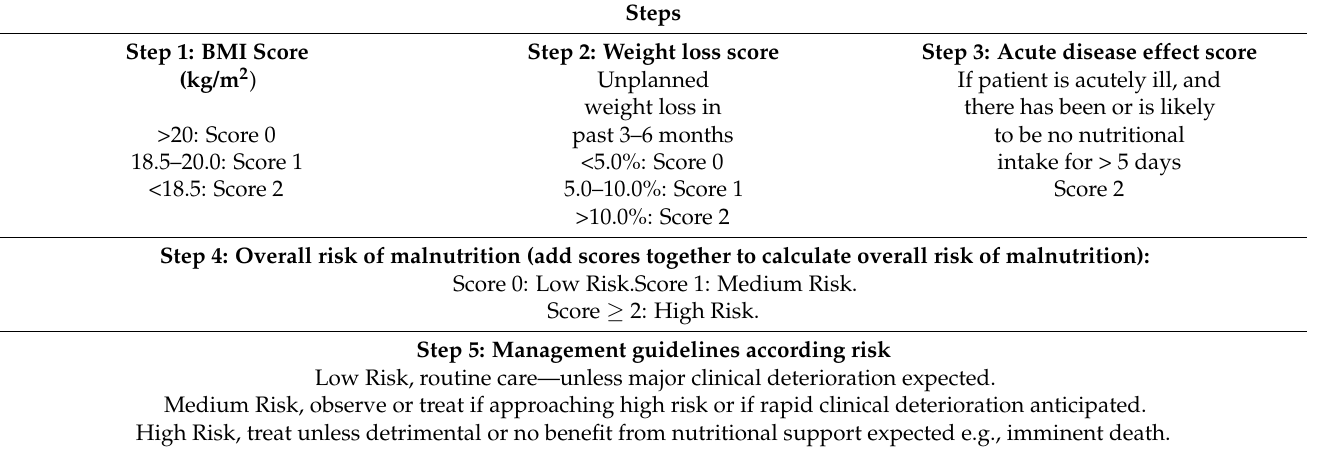
Table 1. MUST five-step screening tool to identify adults who are malnourished or at risk of malnutrition.